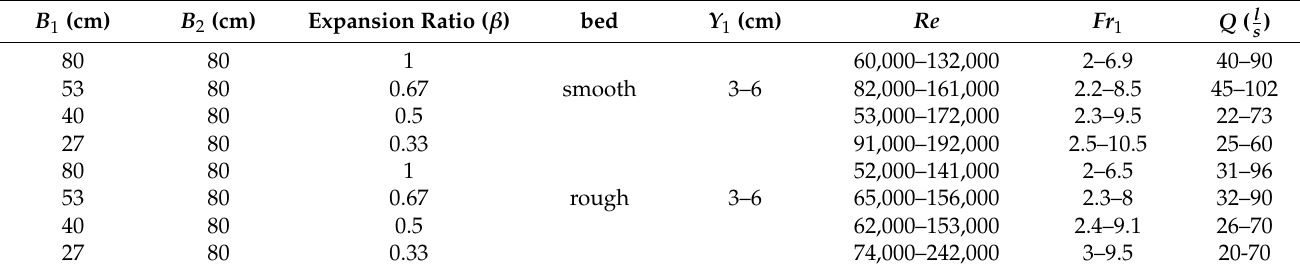
Table 1. Ranges of measured variables.